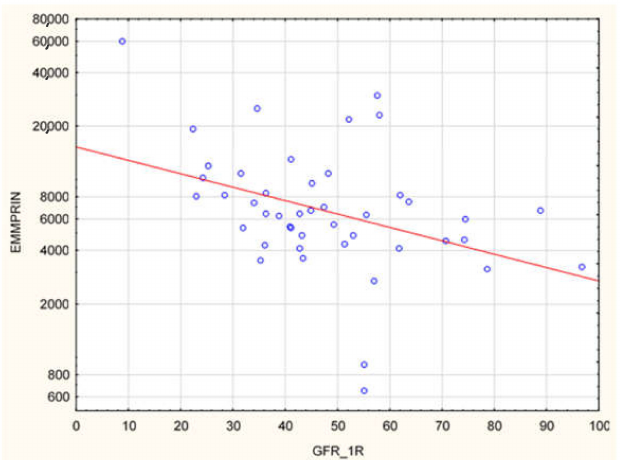
Figure 2. Negative correlation (R = − 0.39, p < 0.05) between EMMPRIN/CD147 serum concentration and eGFR at 1 year after renal transplantation.